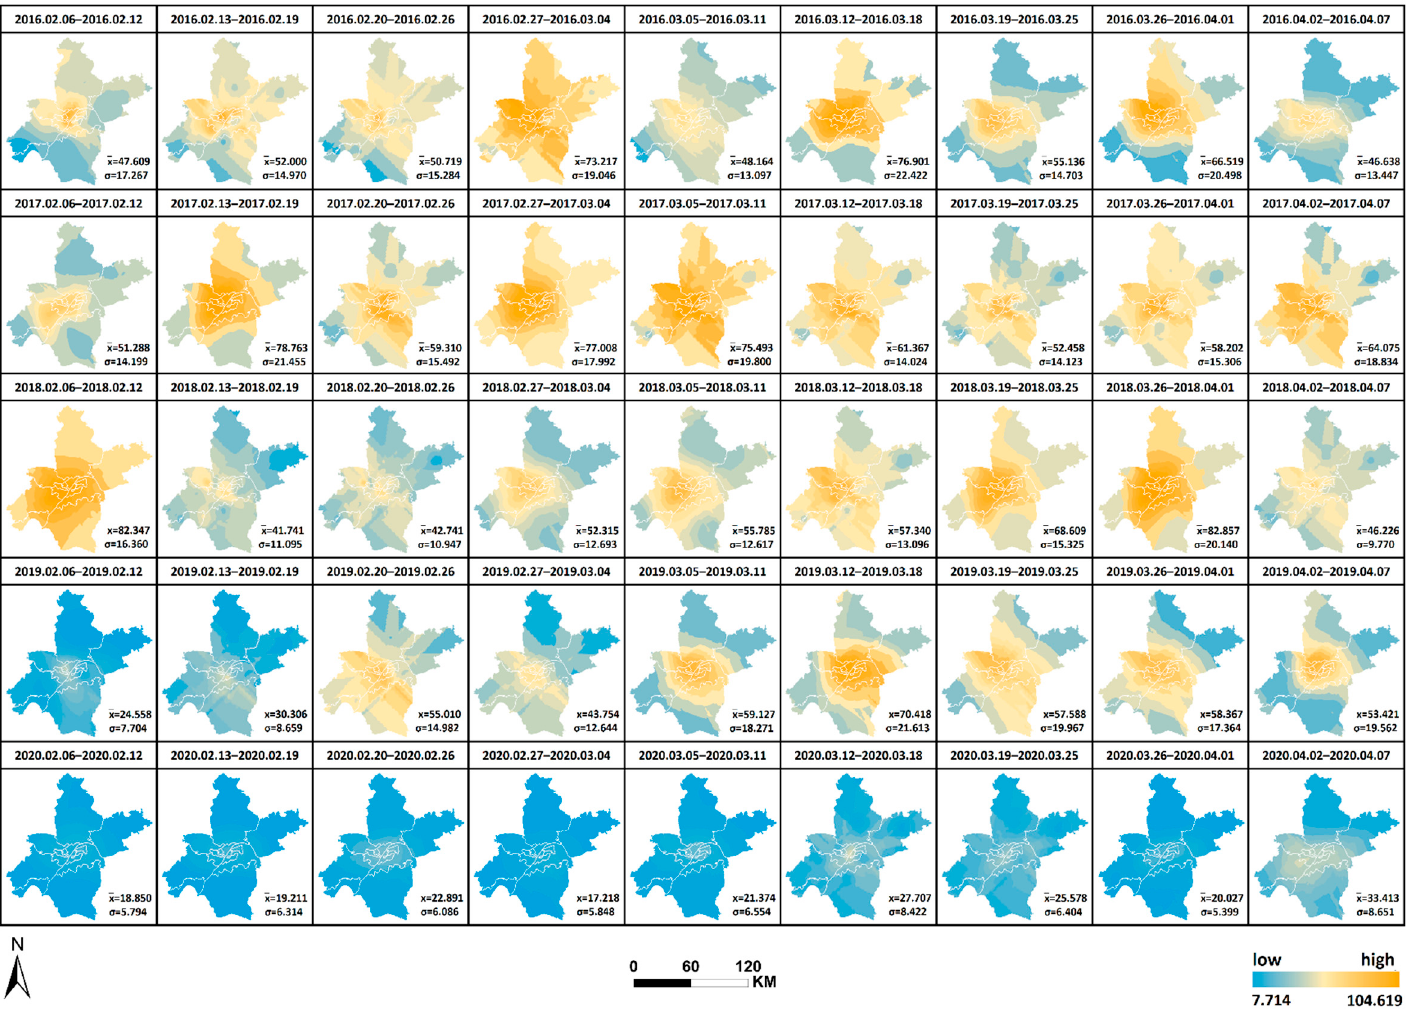
Figure 9. NO 2 interpolation chart from 2016 to 2020.